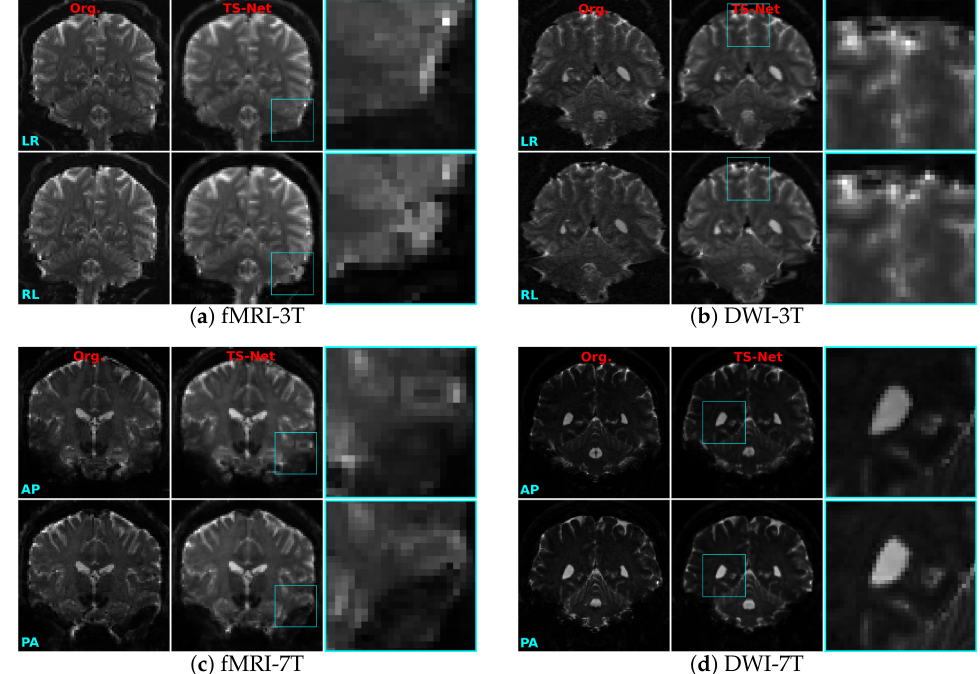
Figure A1. Larger view of the TS-Net outputs from the four test sets. In each subfigure, Column 1 : input uncorrected images. Column 2 : output corrected images produced by TS-Net. Column 3 : the zoomed view of cyan rectangles from the TS-Net